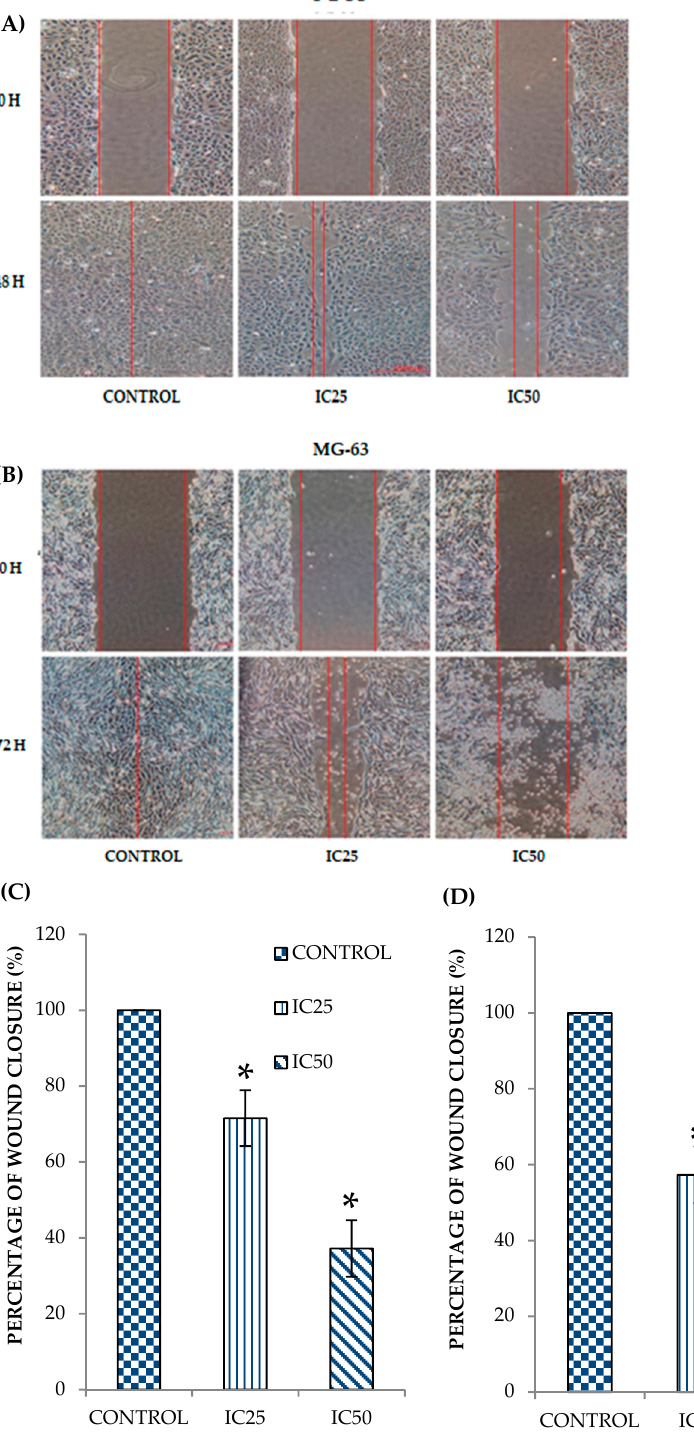
Figure 1. ( A , B ) Images showing wound closing activity of U-2 OS and MG-63 cell lines treated with two different concentrations (IC 25 , IC 50 ) of DK1. U-2 OS untreated group required 48 h to completely heal the wound, while for MG-63, 72 h were needed to close the gap. ( C , D ) Percentage of wound closure for both U-2 OS and MG-63 cell lines when a scratch was introduced. Each experiment was done in triplicate and all data were expressed as mean ± standard error mean (S.E.M). * p < 0.05 compared with corresponding control. (Magnification: 100×).